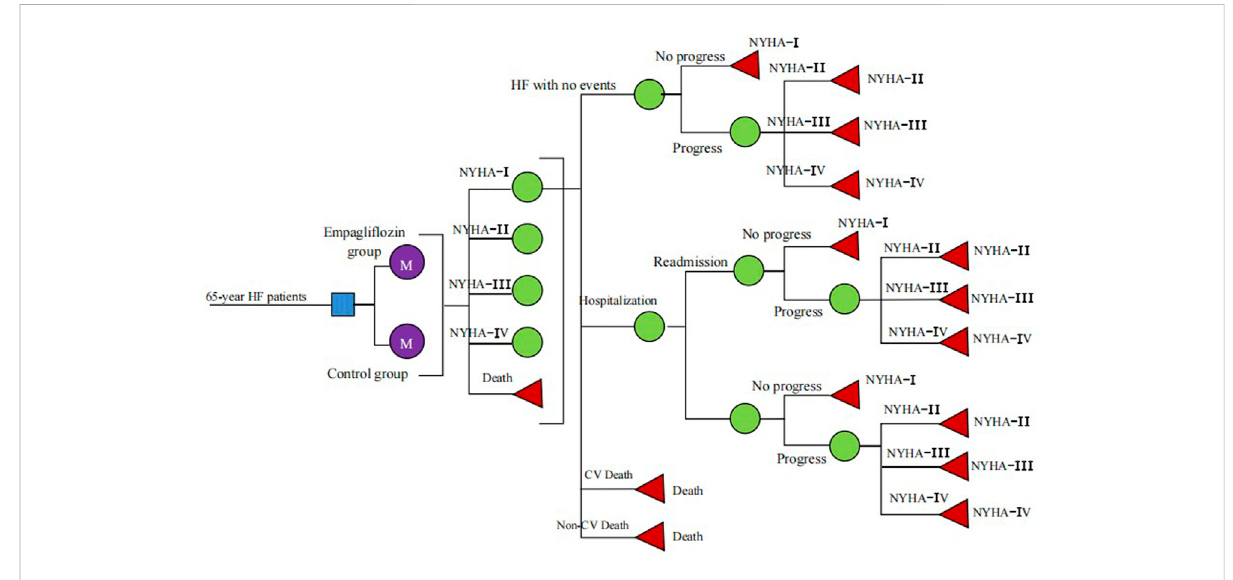
FIGURE 1 Schematic representation of the Markov